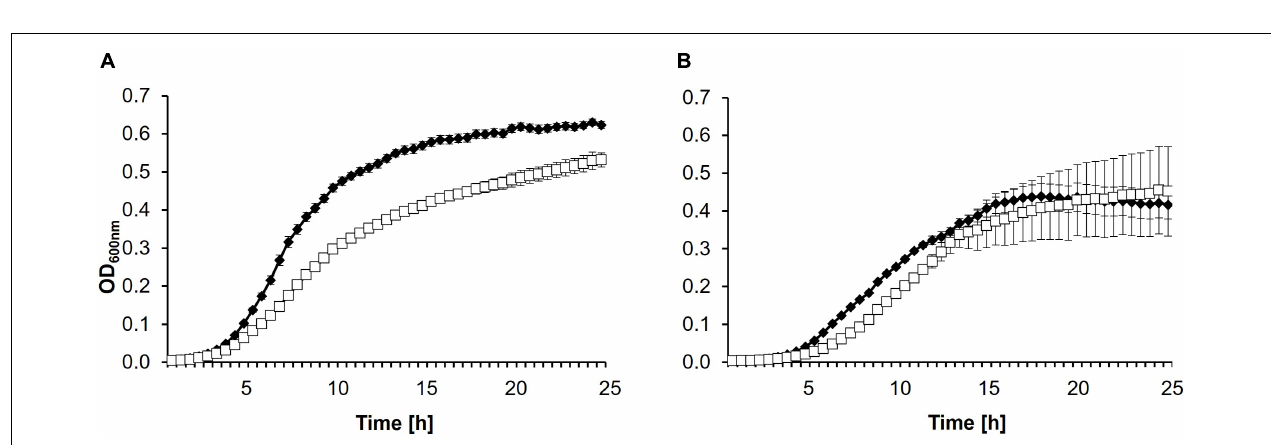
FIGURE 2 | Growth curves of Erwinia amylovora CFBP 1430 and 1430 Y 2 R in (A) LB or (B) MM2 medium. Cell counts were adjusted to 10 5 CFU/ml before incubation at 28 ◦ C under double orbital shaking for 24 h in a plate reader. Optical density (OD 600 nm ) was measured every 30 min. Each strain was measured twice independently with eight replicates per run. Error bars indicate the standard deviation. The experiment was performed with three biological and three technical replicates.